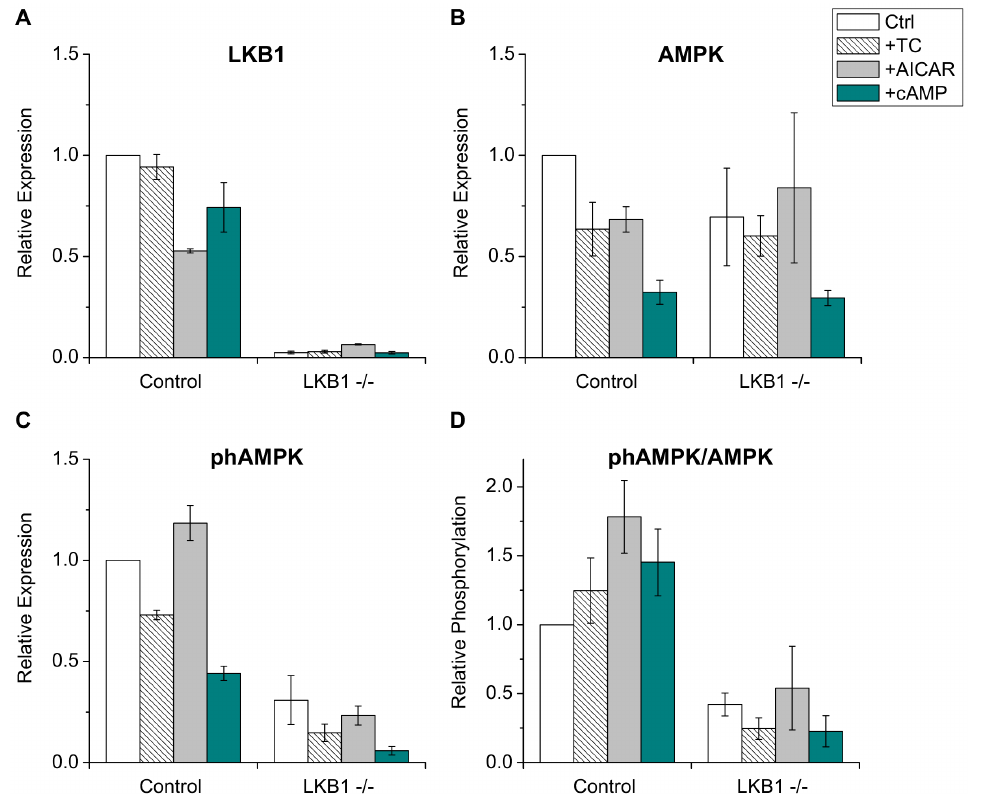
Figure 5. Expression and phosphorylation of AMPK. Western blot analyses were performed with total cell lysates of cultured hepatocytes on day 6 using antibodies specific to LKB1 ( A ), AMPK ( B ), and phospho-Thr172 AMPK (phAMPK) ( C ). Immunoblots were quantified by densitometry; data were expressed as relative values to the expression level of untreated control cells. ( D ) Relative phosphorylation of AMPK was determined by dividing the phAMPK value by the total AMPK expression level. Pretreatments: TC – 100 m M taurocholate, AICAR - 500 m M AICAR, cAMP - 200 m M 8-Br-cAMP. Means 6 S.E.M. of three experiments are shown. LKB1 expression is absent in the hepatocytes of the liver-specific LKB1 2 / 2 , whereas AMPK expression is 64% of the control level. Both absolute and relative level of phosphorylated AMPK is greatly reduced in the LKB1-decifient hepatocytes.